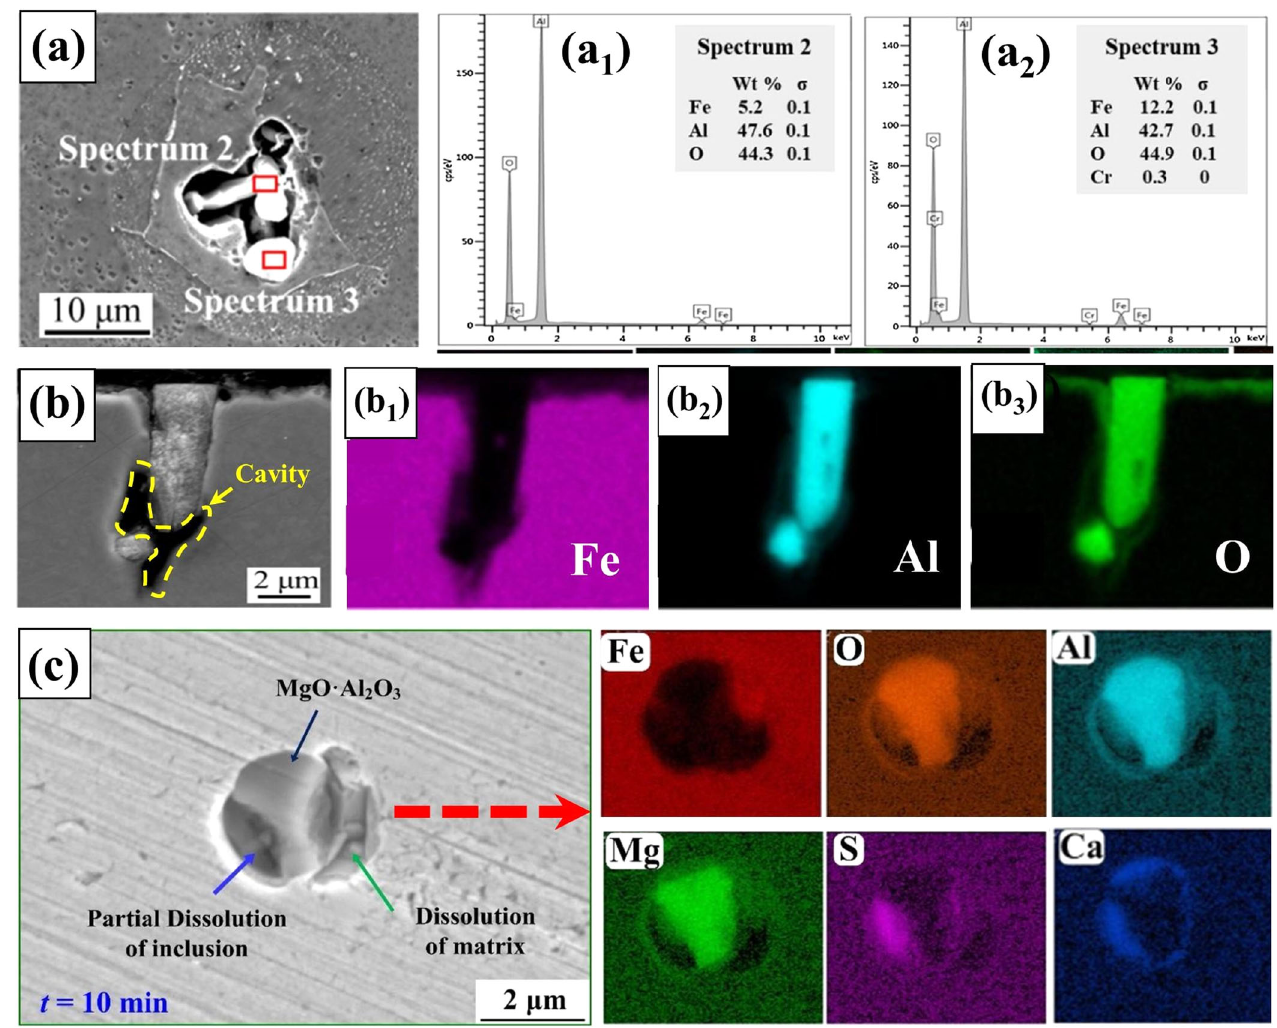
Fig. 8 Corrosion behavior and composition variation of Al 2 O 3 -containing inclusions in steel. a , c Typical SEM images. b Cross-sectional images and ( a 1 , a 2 , b 1 , b 2 , b 3 ) corresponding element distribution of the steel containing oxide spinel inclusions (Al-killed steel containing Al 2 O 3 inclusions immersed in 1 M NaCl + 0.5 M Na 2 SO 4 + 0.5 M CaCl 2 for 30 min was shown in a – b 3 , while X70 steel containing complex x CaS· y MgO· z Al 2 O 3 inclusions immersed in 0.0111 M CaCl 2 + 0.0468 M NaCl + 0.0142 M Na 2 SO 4 + 0.0197 M MgSO 4 ·7H 2 O + 0.0293 M KNO 3 + 0.0151 M NaHCO 3 for 10 min was depicted in c ) after removal of corrosion product 24,84